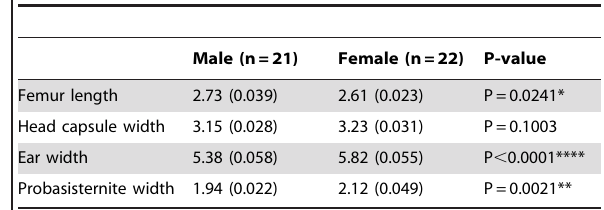
Table 1. Mean length and width of different morphological structures of males and females in mm (s.e.m. in parentheses).